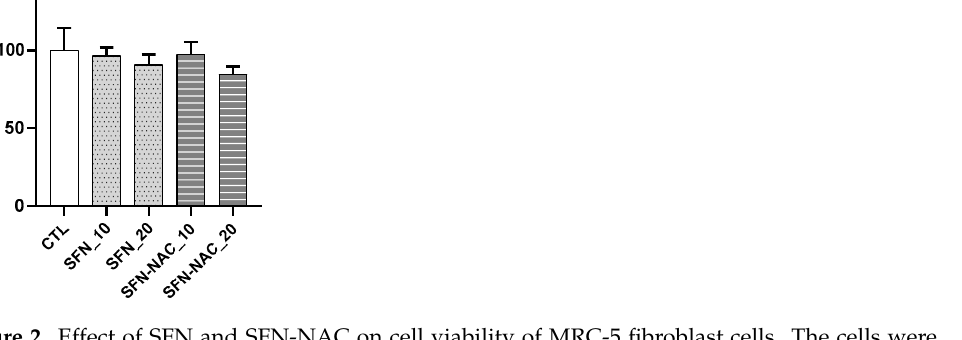
Figure 2. Effect of SFN and SFN-NAC on cell viability of MRC-5 fibroblast cells. The cells were treated with indicated concentrations (10 and 20 µ M) of SFN and SFN-NAC for 48 h. Data values are expressed as the mean ± standard deviation of at least three different experiments. SFN, sulforaphane; SFN-NAC, sulforaphane N -acetylcysteine; CTL, control.